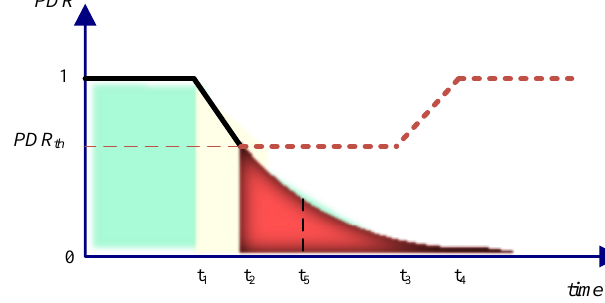
Figure 8. Resiliency curve of the SCN model for Case-IV .